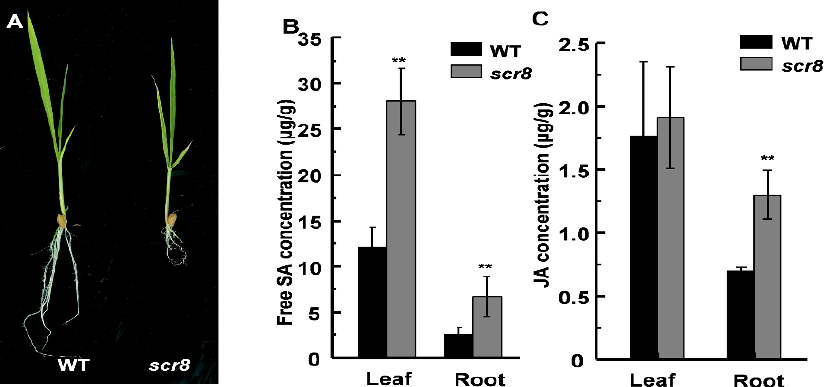
Figure 5. The contents of SA and JA in WT and scr8. ( A ) The phenotype of WT and scr8 in seedling. Scale bar, 1cm. ( B ) Contents of free SA in WT and scr8 leaves and roots (n = 3). ( C ) Contents of JA in WT and scr8 leaf and roots (n = 3). Error bars represent SD. ** Significant difference at p < 0.01 compared with the WT by Student’s t -test.